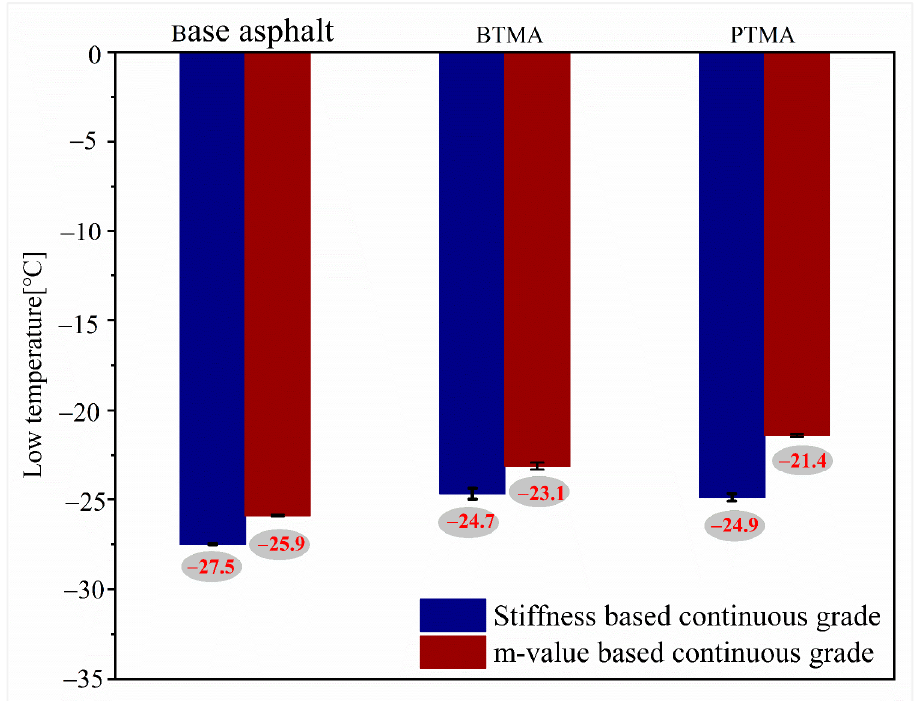
Figure 11. m ‐ value and stiffness ‐ based continuous grading low temperature for all binders. Figure 11. m-value and stiffness-based continuous grading low temperature for all